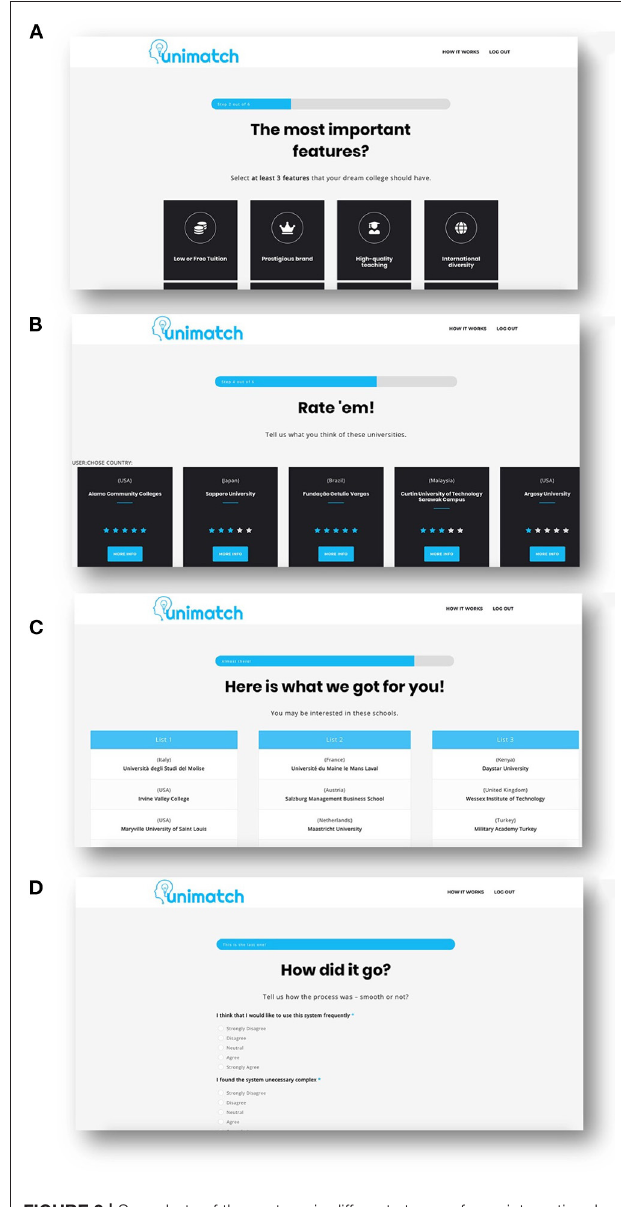
FIGURE 2 | Snapshots of the system, in different stages of user interaction. In (A) , users had to select at least three features they found important when selecting a university. In (B) ,they were asked rate at least three universities, while in (C) they were presented three personalized recommendation lists with universities. Panel (D) depicts the System Usability Questionnaire. Not depicted are the demographics and user evaluation